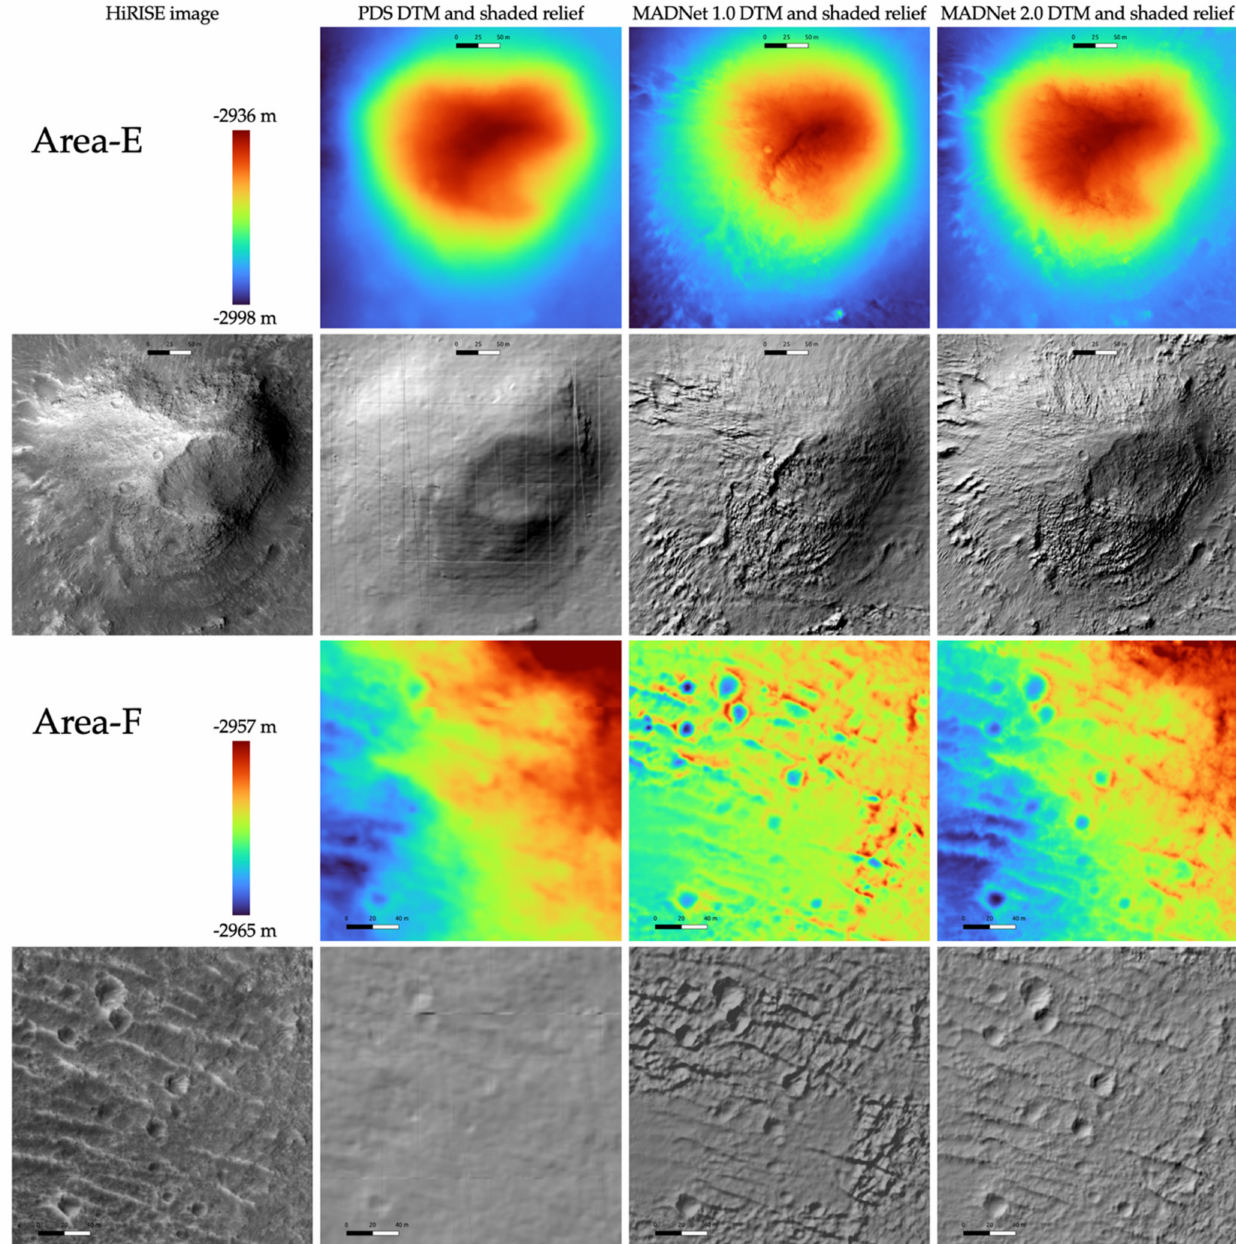
Figure 13. Examples of zoom-in views of the 1 m/pixel PDS HiRISE DTM, 50 cm/pixel MADNet 1.0 DTM, and 25 cm/pixel MADNet 2.0 DTM, produced from a single HiRISE image